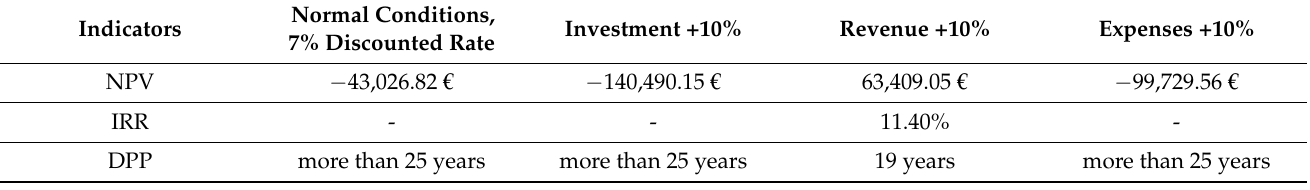
Table 9. Financial indicators for the location Cerklje.